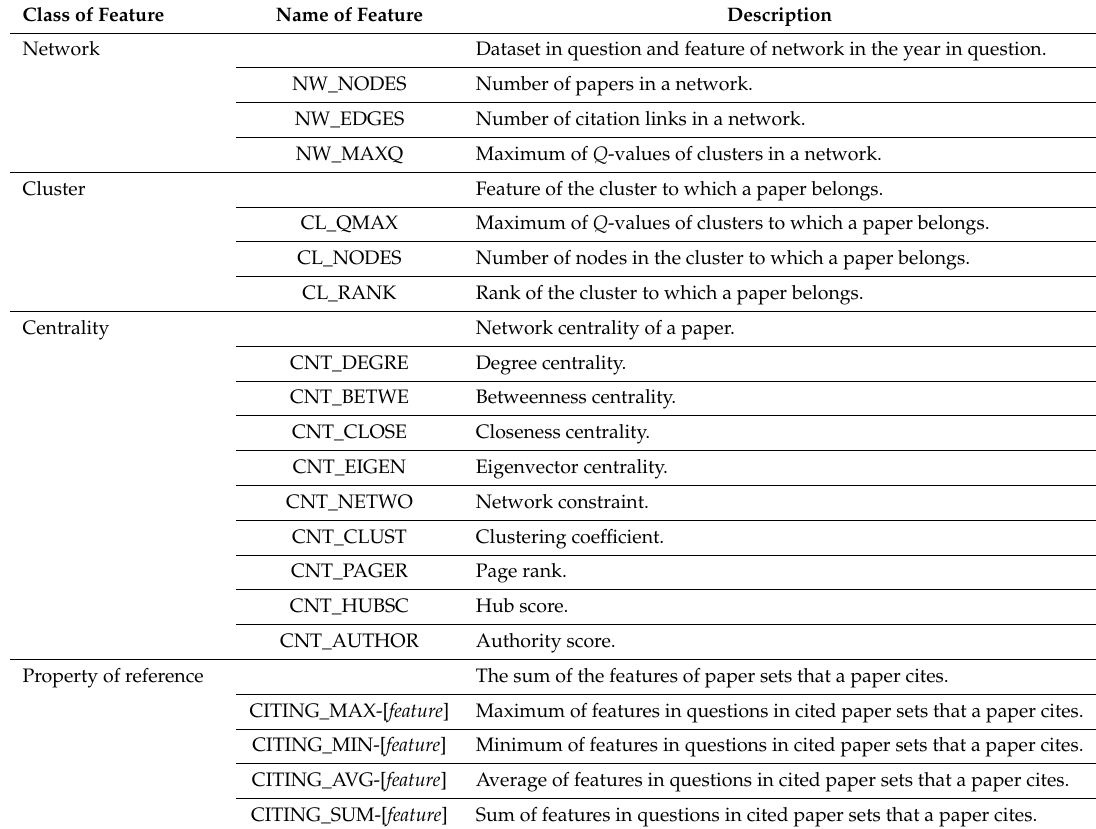
Table 1. Features used in the emergence prediction